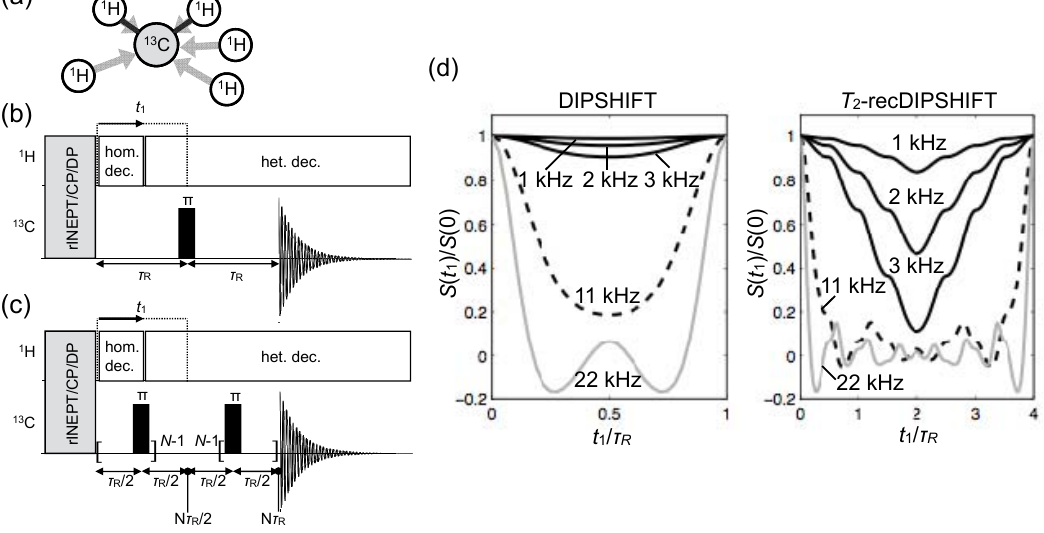
Figure 10. Carbon-detected local field spectroscopy. ( a ) Illustration of the basic carbon-detected local field (CDLF) configuration where carbon magnetization evolves under multiple proton dipolar couplings; Pulse sequences of the ( b ) dipolar chemical-shift correlation (DIPSHIFT) and ( c ) T 2 -recDIPSHIFT methods; ( d ) Comparison of DIPSHIFT and T 2 -recDIPSHIFT t 1 curves for a number of distinct C–H couplings. Note that the couplings shown correspond to the effective heteronuclear dipolar coupling under a given homonuclear decoupling